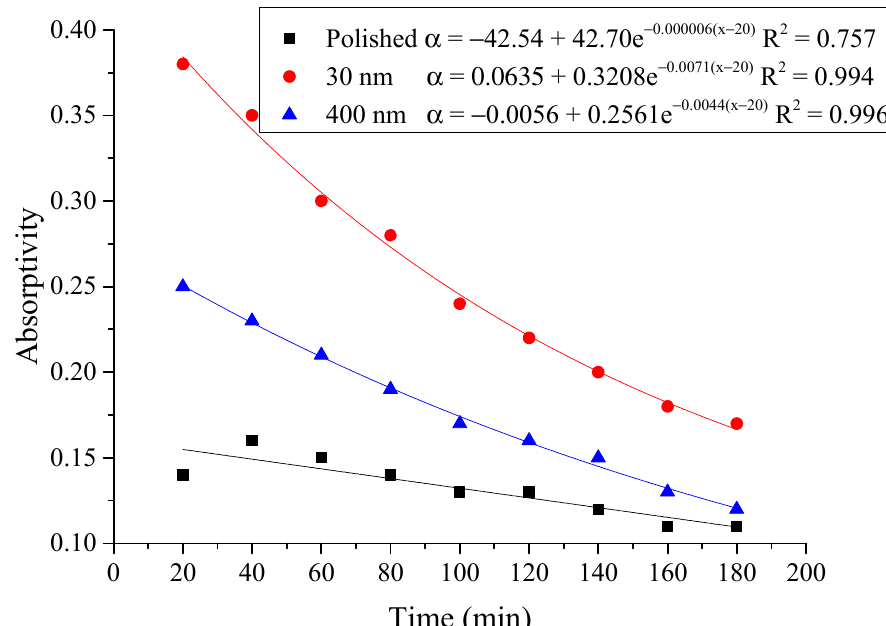
Figure 17. Variation of the average absorptivity for the testing rigs operated under the simulated radiation of 400 W / m 2 .